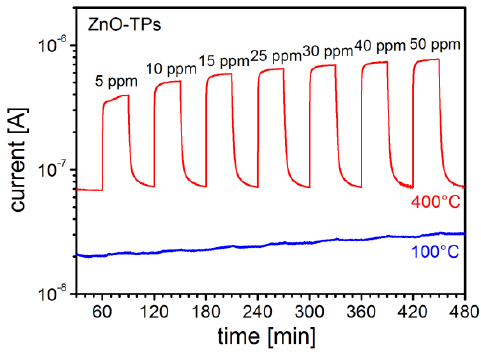
Figure 5. Comparison of the dynamic responses of a sensors with ZnO-TPs only towards different concentrations of ethanol at 100 °C and 400 °C (RH 30%).